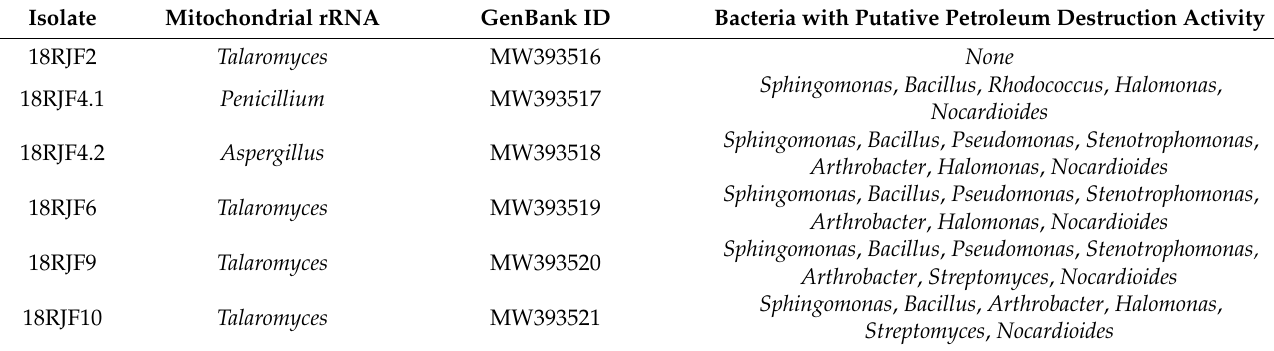
Table 3. Microorganisms in the samples of the TS-1 fuel based on rRNA sequencing data: fungal genera based on mitochondrial DNA sequence, as well as their NCBI GenBank IDs and bacteria with putative oil degradation activity.